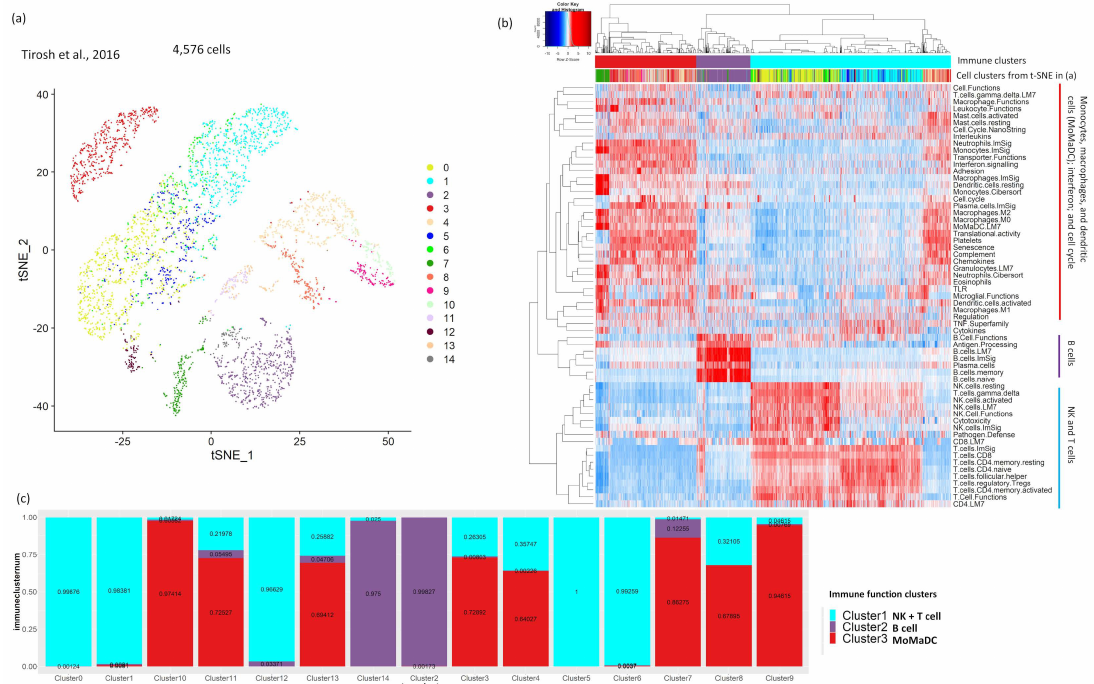
Figure 1. ssGSEA of scRNA-Seq data of melanoma tumor samples identifies three dominant immune- function-associated cell clusters. One of these clusters is enriched for monocytes, macrophages, dendritic cells, mast cells, and neutrophils; one is enriched for B-cell functions; and one is enriched for NK- and T-cell functions. ( a ) Analysis of a melanoma scRNA-Seq data set identifies 14 cell clusters from unsupervised t-SNE clustering. ( b ) These clusters were assigned to three distinct sets of immune functions using ssGSEA, as seen from the heat map (one related to monocytes, macrophages, dendritic cells, and Toll-like receptor (TLR); one related to B-cell functions; and one related to NK- and T-cell functions). ( c ) The stacked bar plot shows that cell clusters 0, 1, 5, 6, and 12 are enriched for NK- and T-cell functions; cell clusters 2 and 14 are enriched for B-cell functions; and cell clusters 7, 9, and 10 are enriched for functions related to monocytes, macrophages, and dendritic